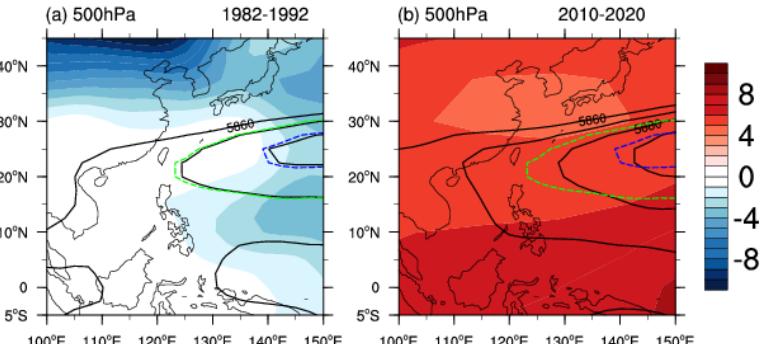
Figure 9. The GHT500 anomalies (shaded, units: gpm) and the WNPSH represented by a black con- tour of 5870 gpm in the warm season (May–September) 1982–1992 ( a ) and 2010–2020 ( b ). Anomalies are relative to the mean climatology of May–September 1983–2012. The mean position of WNPSH is denoted by the green contour line of 5870 gpm and the blue contour line of 5880 gpm at 500-hPa.